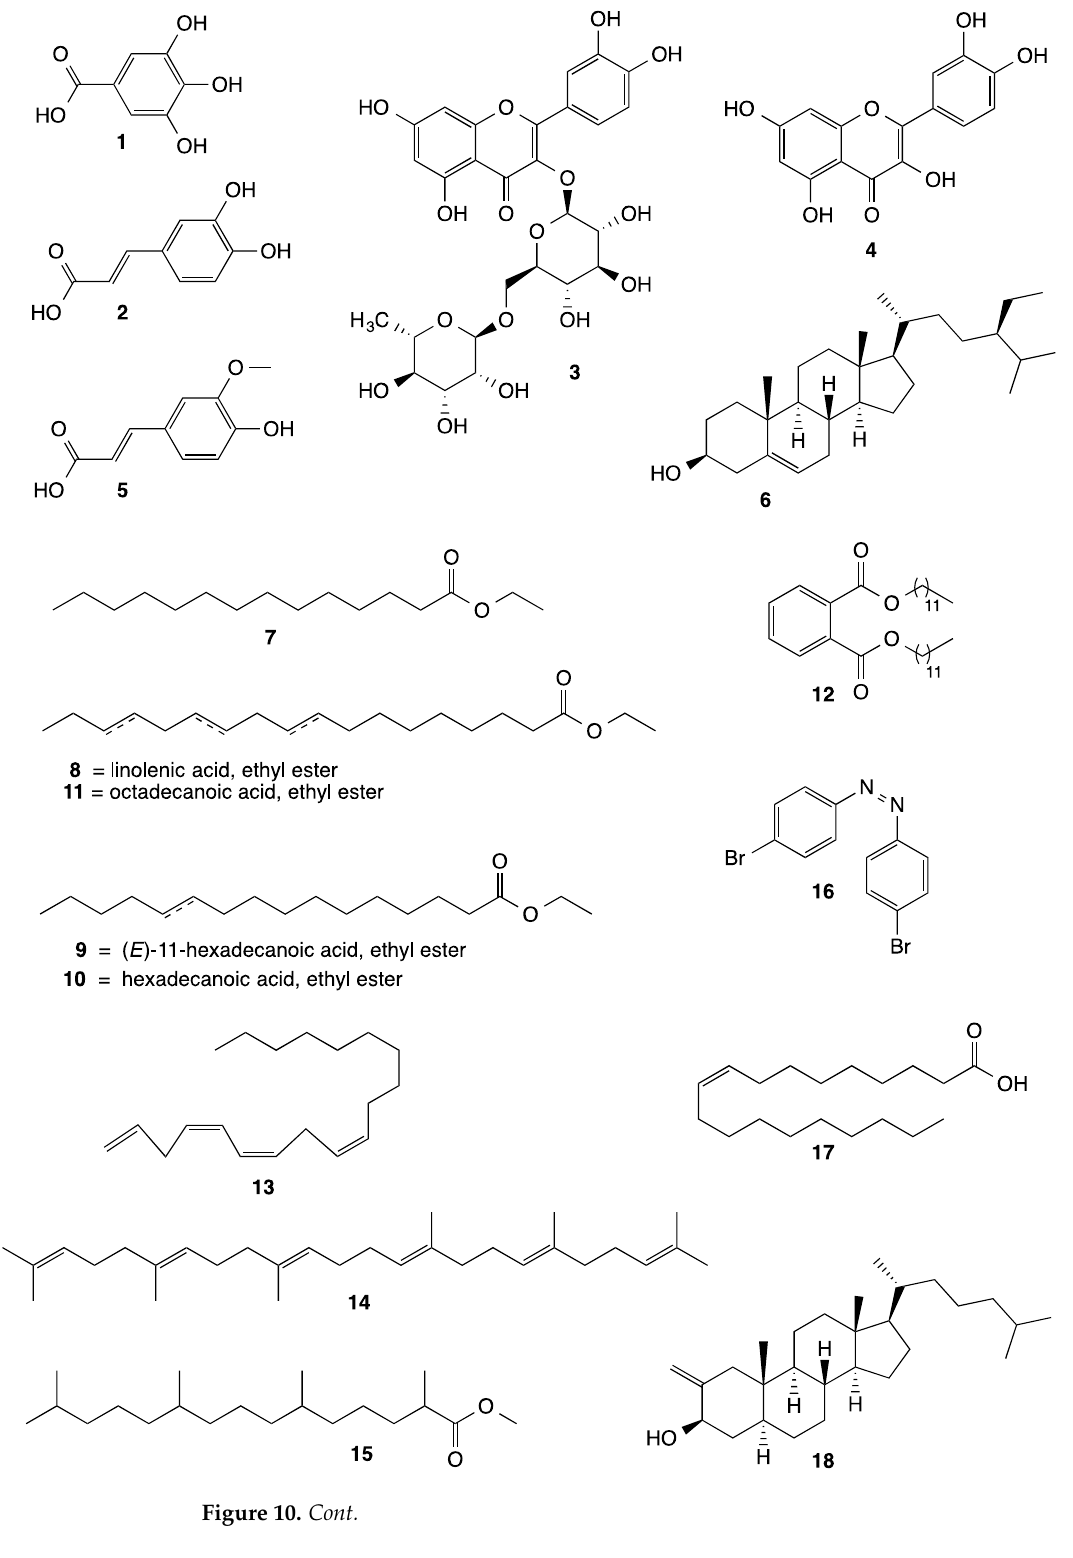
Figure 10. Molecular structure of some compounds isolated from species of the genus Malachra L. Figure 10.